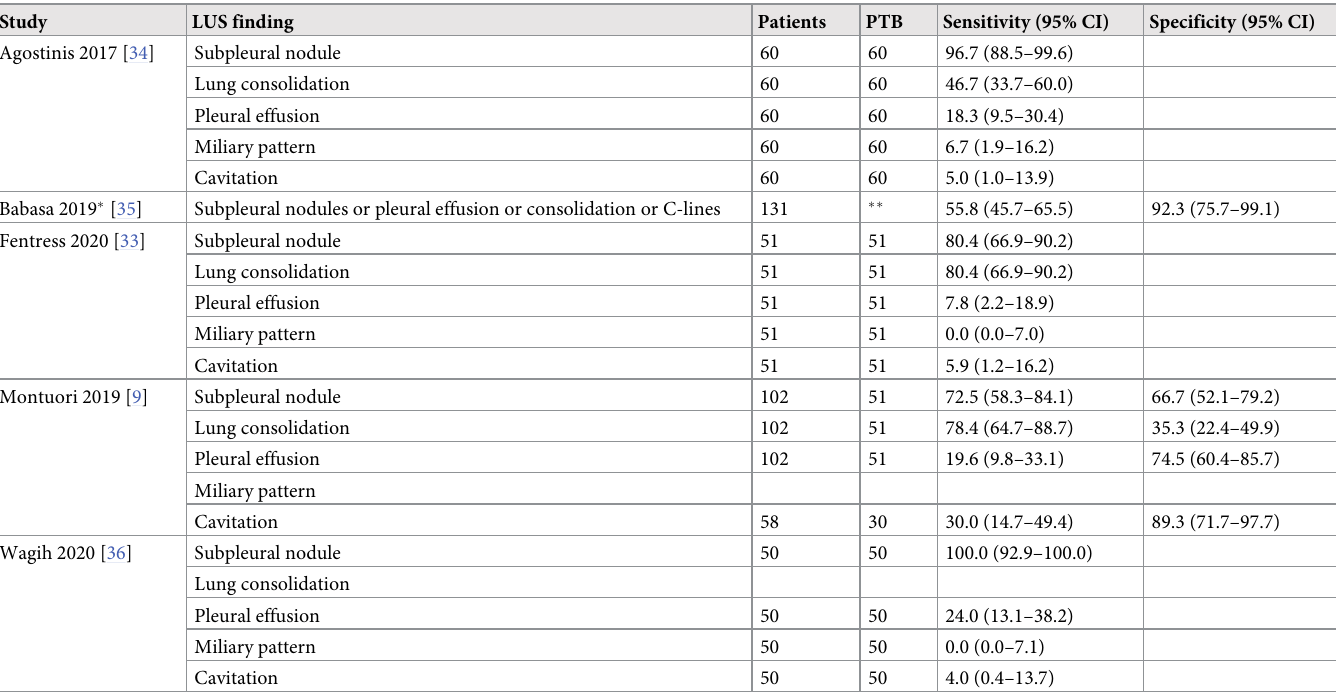
Table 5. Diagnostic accuracy of lung ultrasound findings in adults.